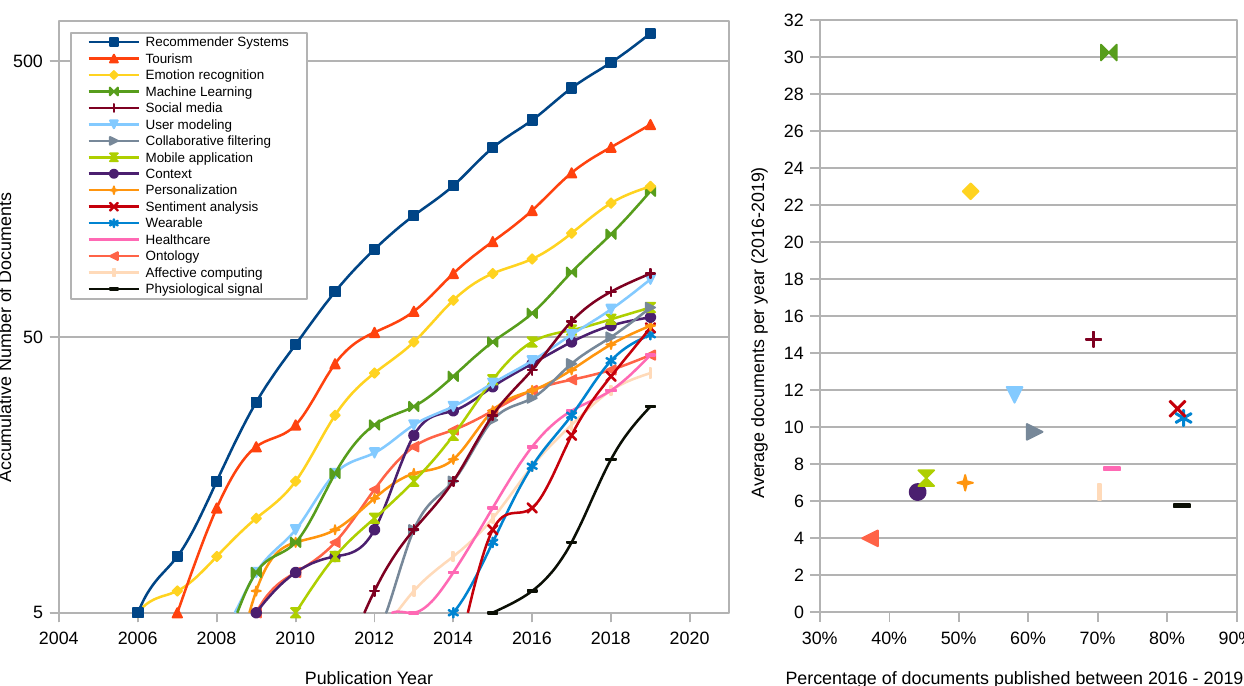
Figure 3. Machine learning, sentiment analysis, and wearable technology applications trends in recommenders system